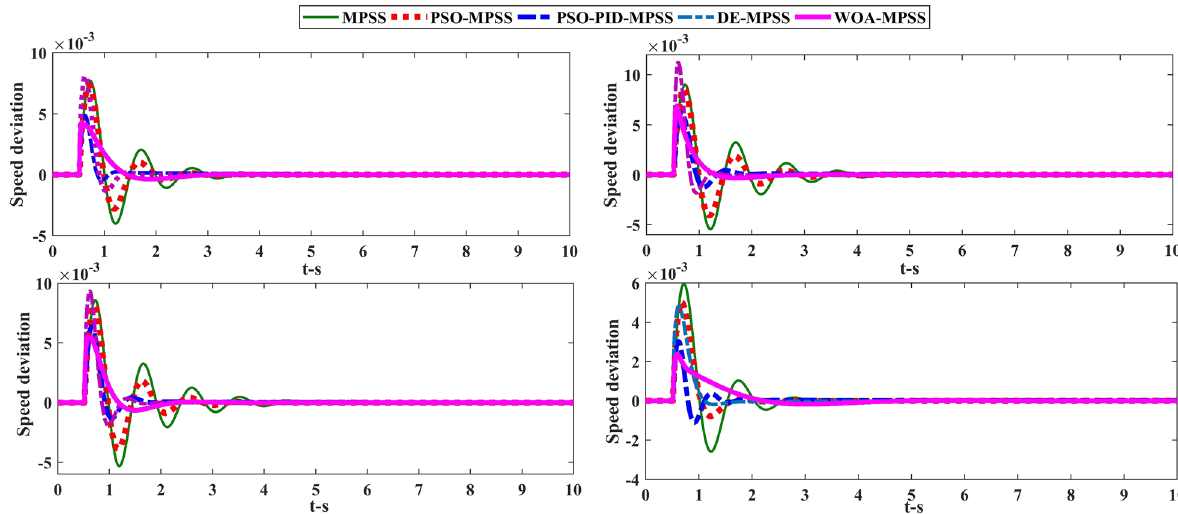
Fig. 8 System response plots for the disturbance of 10% step change at ΔT